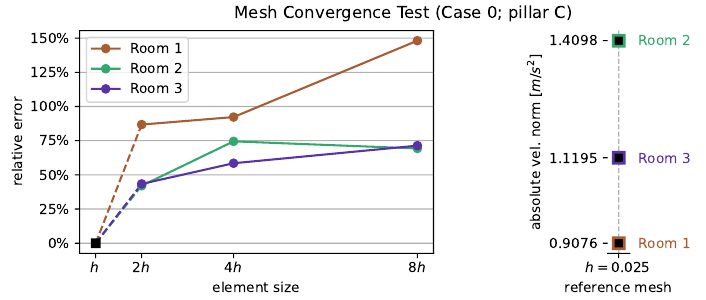
Figure 14. Percentage relative error as a function of the mesh element size ( left ); absolute velocity magnitude for the reference mesh ( right ). The error decreases as the factor multiplying h decreases, thus indicating that the numerical solution on coarser meshes should converge to that over the (finest) reference mesh (black square marker) through h -refinement. On the right, the colored borders indicate the maximum velocity reached at the pillar C for Case 0 inside each room computed for the reference